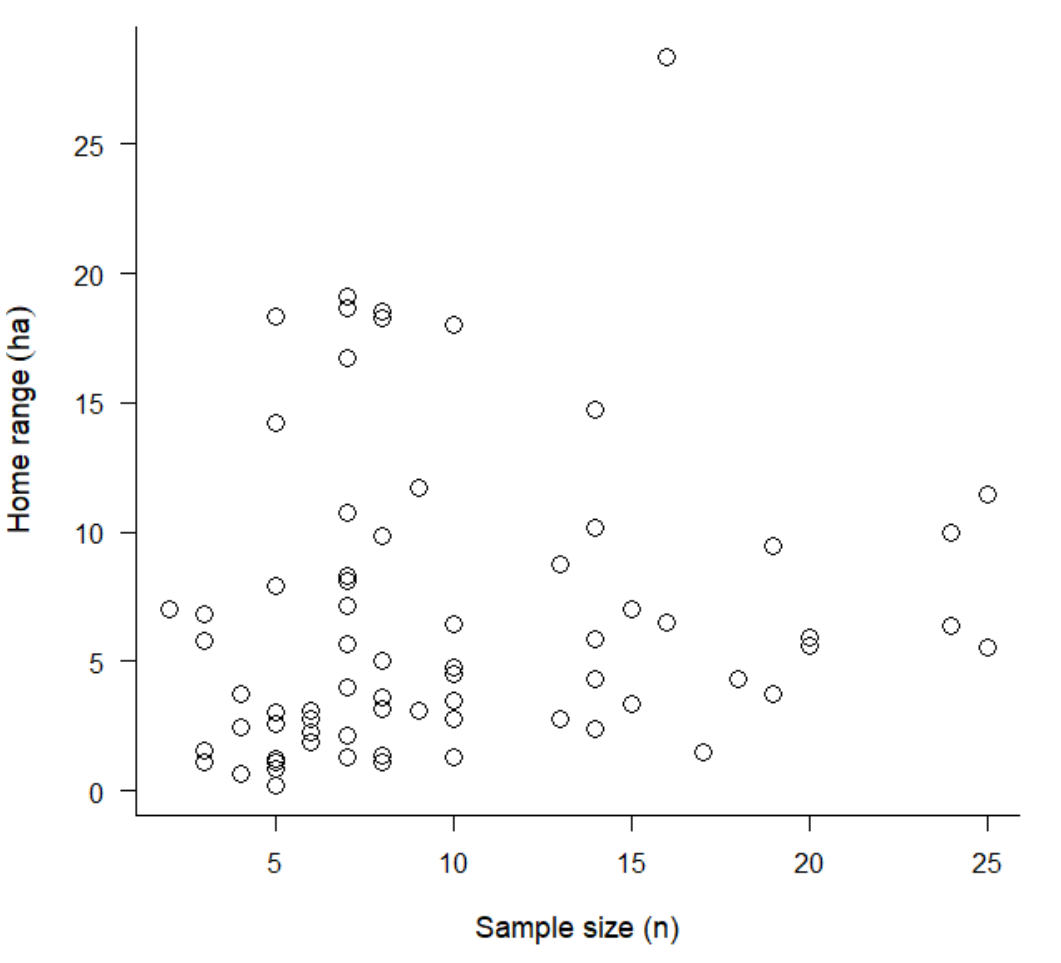
Figure 1. Raw mean HR estimates as a function of study sample size. The relationship was not significant ( β = 0.077, df = 45, t = 0.542, p = 0.591). Relocation status influenced HR size in T. carolina , and there were no appropriate data for T. ornata . not relocated (Table